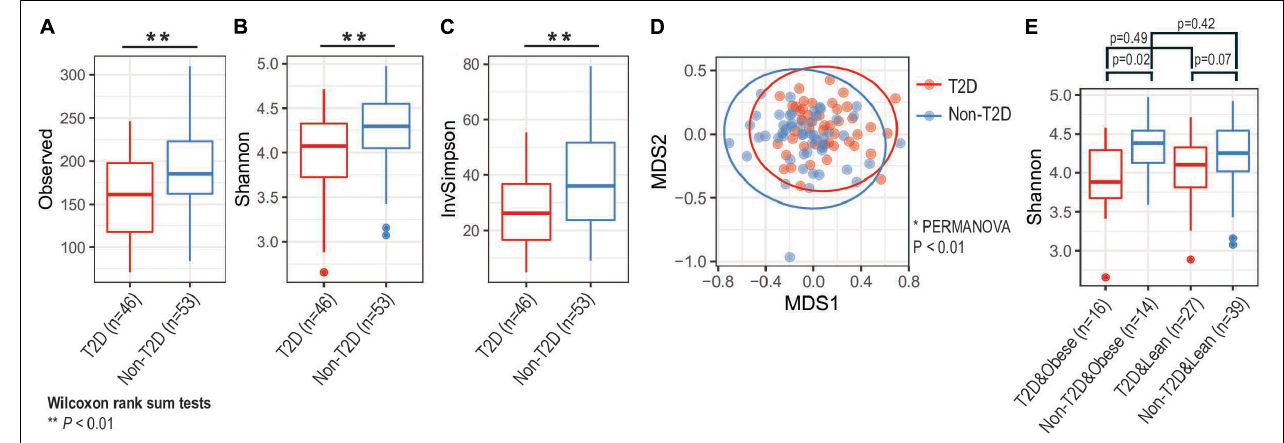
FIGURE 1 | Analysis of microbial diversity. Based on (A) observed, (B) Shannon, and (C) inverse Simpson diversity, we found that alpha-diversity of oral microbiota decreased among diabetic groups (** Wilcoxon rank sum tests p -value < 0.01). (D) Principal coordinate analysis (PCoA) identified that oral microbiota compositions were distinct by diabetic status (* PERMANOVA test p -value < 0.01). Large circles represent 95% confidence ellipse for each group. (E) Obesity status did not significantly change alpha-diversity changes (Wilcoxon rank sum tests). T2D, type 2